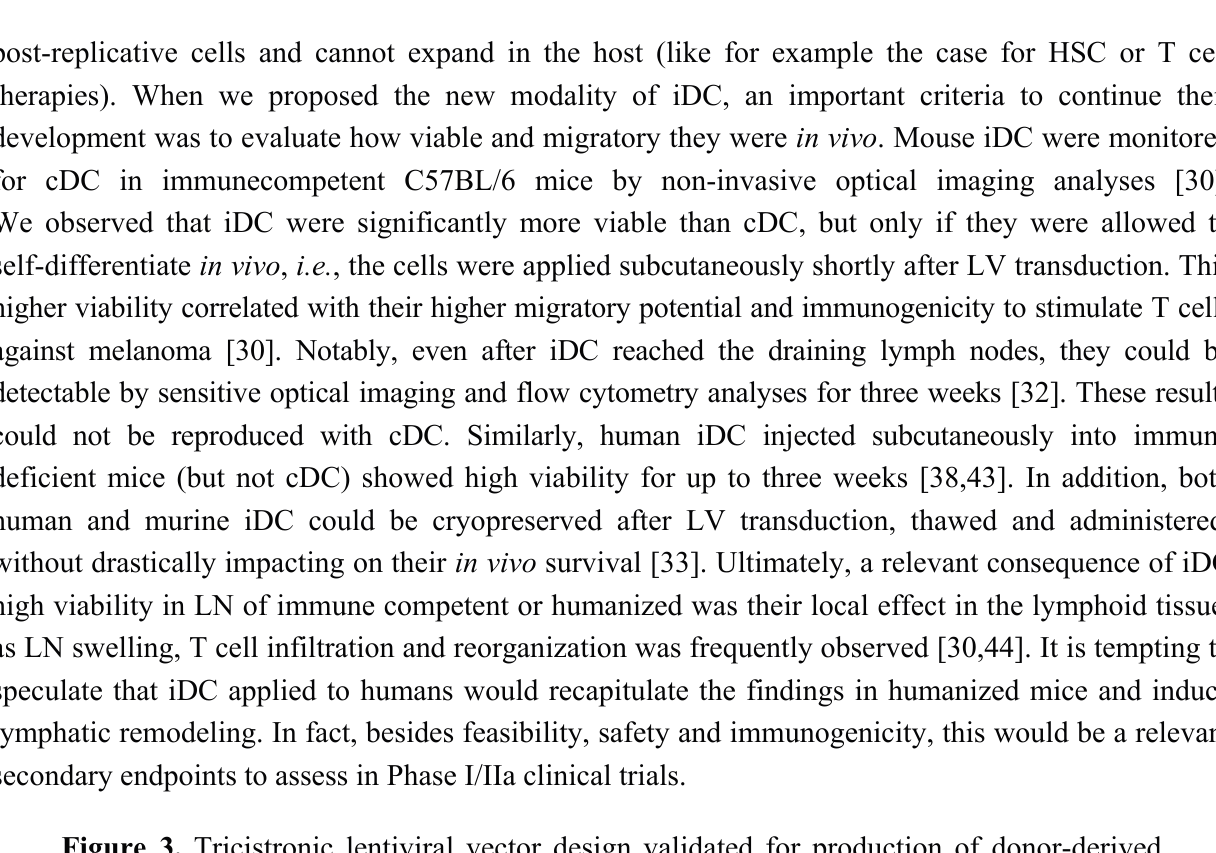
Figure 3. Tricistronic lentiviral vector design validated for production of donor-derived SmyleDCpp65 in vivo in humanized mice recapitulating human hematopoietic stem cell transplantation and in vitro T cell stimulation assays using peripheral blood mononuclear cells from stem cell